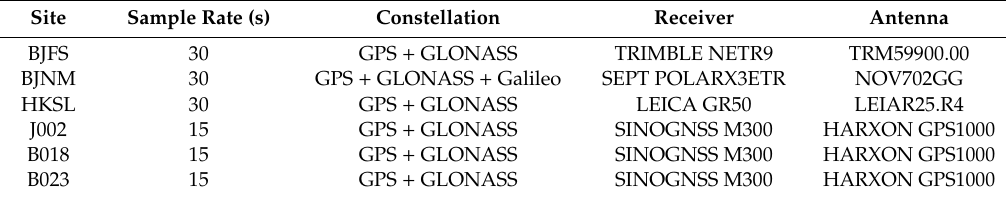
Figure 1. Distribution of GNSS stations for refinement modeling. Table 3. Sample rate, constellation, receiver, and antenna of refinement GNSS stations.